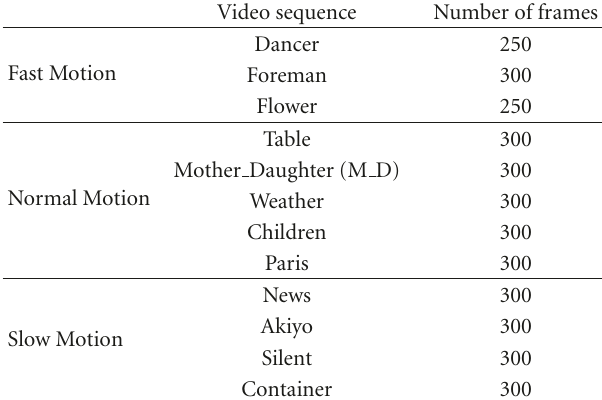
Table 2: Testing video sequences.